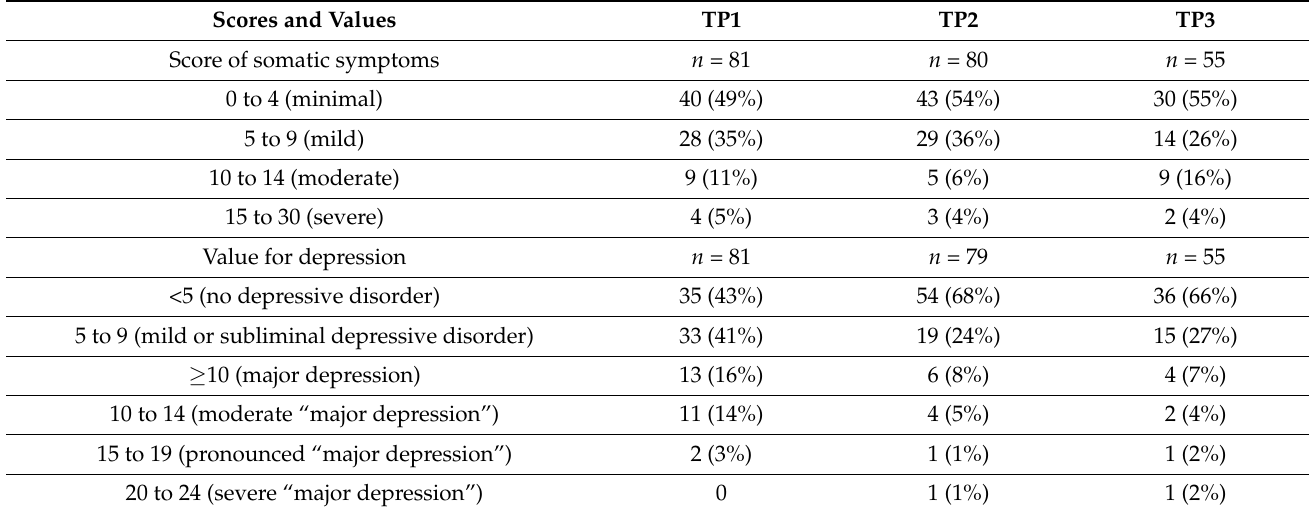
Table 6. Frequency and rates of the scores for different manifestations of the somatic symptoms value (PHQ-15) and frequency and rate of values for the different manifestations of depression (PHQ-8 and PHQ-9).